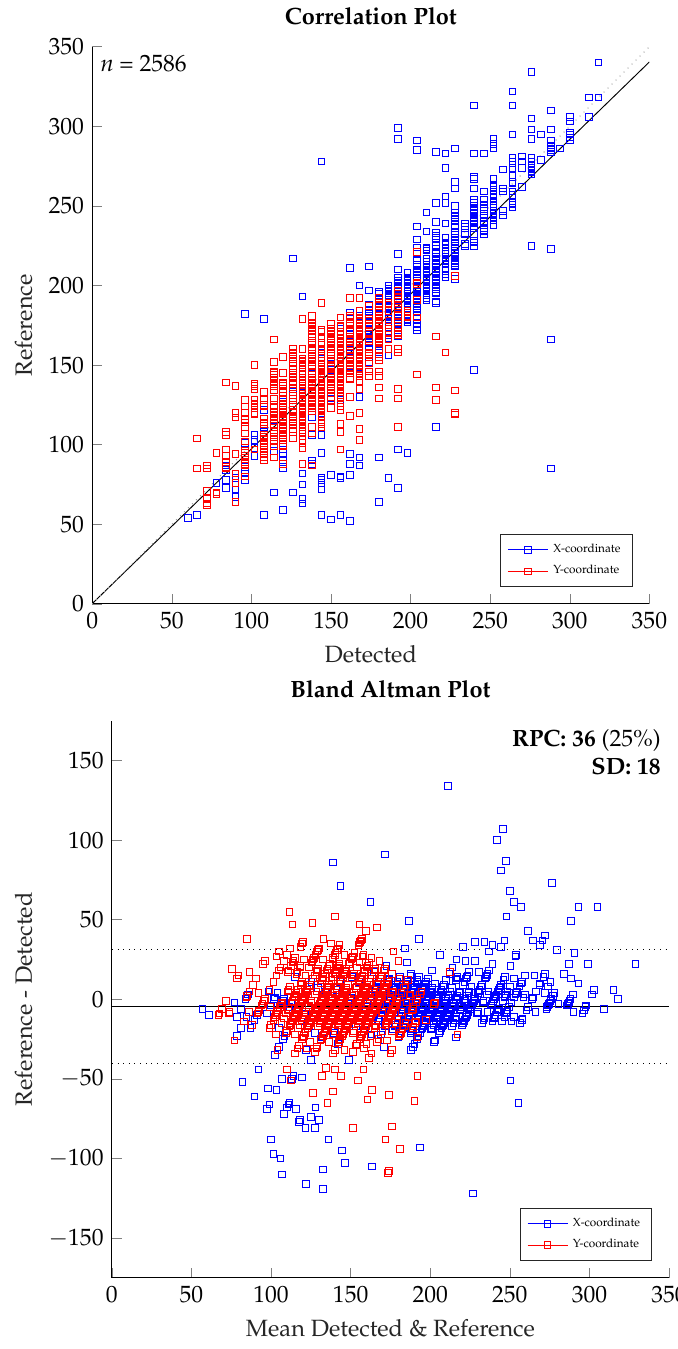
Figure 6. Correlation and Bland–Altman plot between reference and detection is shown for the down- scaled video with the image size 31 24 pixel (1/144th of the original size). Due to the upscaling × to match the reference, quantization artifacts are